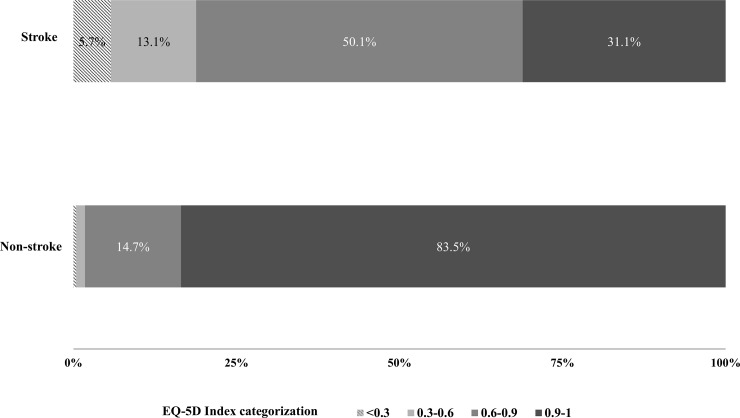
Distribution of HRQoL in stroke and non-stroke subjects.The four categorization of EQ-5D index was used; 0.9–1 for satisfied; 0.6–0.9 for little dissatisfied; 0.3–0.6 for moderately dissatisfied; <0.3 for severely dissatisfied.